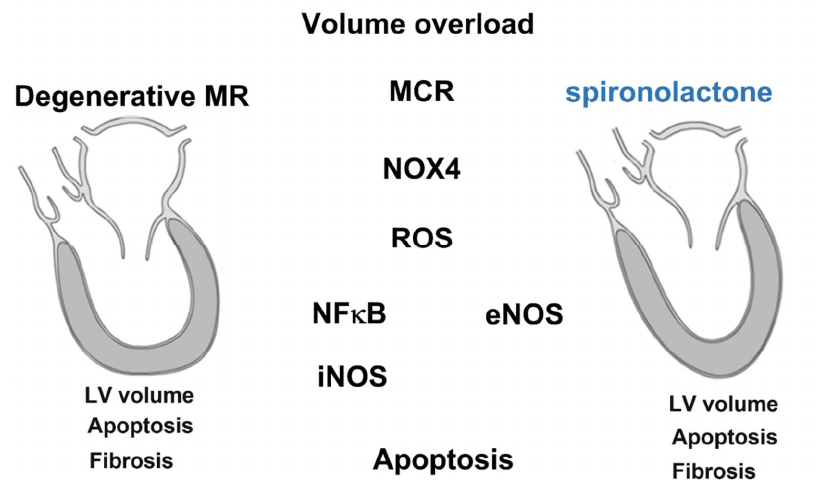
Figure 6. Summary of mineralocorticoid receptor (MCR) antagonists in mitigating mitral regurgitation (MR)-induced cardiac injury and apoptosis through the MCR/NOX4 pathway. Cardiomyocytes subjected to MR stress increase MCR and NOX4 expression and induce iNOS expression and inhibit eNOS expression, which contributes to apoptosis. This phenomenon could be prevented by inhibiting MCR expression with mineralocorticoid receptor antagonist treatment.